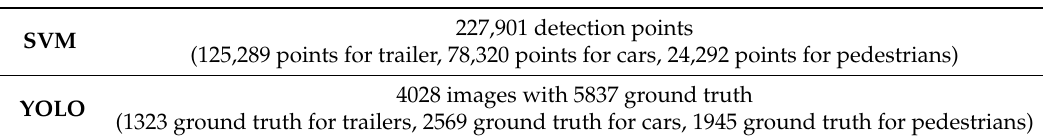
Table 4. Labeled dataseet for SVM and YOLO.